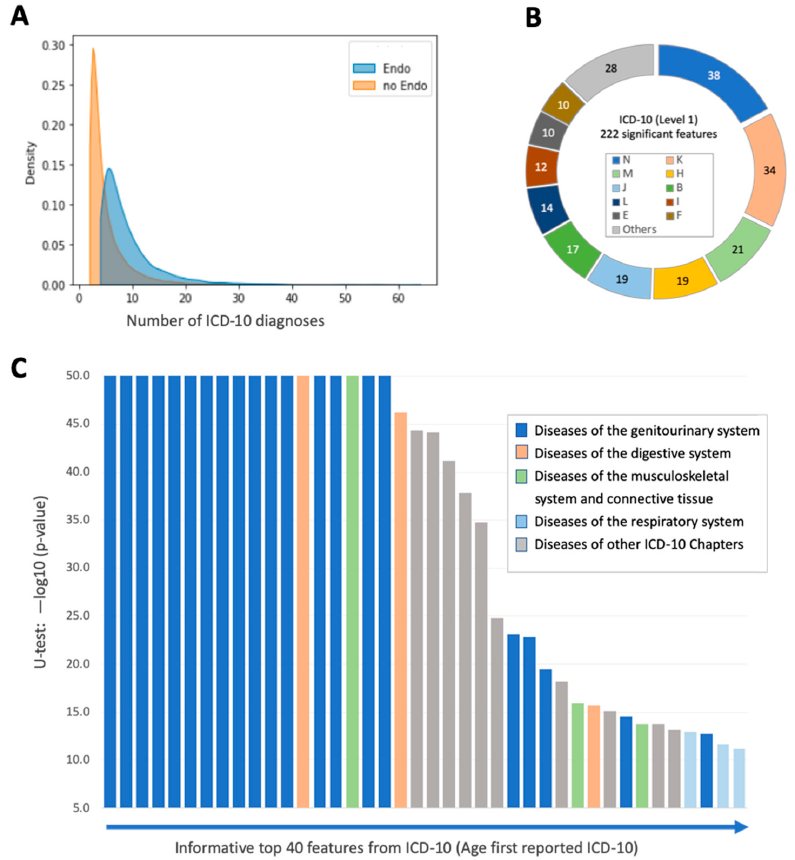
Figure 4. ICD-10 in control and endo-groups. ( A ) The distribution of the number of ICD-10 diagno- ses in the control and endo-groups (orange and blue, respectively) was significant using the Mann– Whitney U-test ( p -value < 0.001) and SMD = 0.471. The median value of the number of ICD-10 diag- noses per individual for the control and endo-groups is 1 and 4, respectively. ( B ) Partition of all 222 statistically significant informative features from the ICD-10 based model (U-test, p -value < 0.05). Each feature was tested for the statistical difference between the control and the endo-group. The partition is according to the ICD-10 level 1 first letter (A-Q). The level 1 letters with less than 10 features are unified (‘others’). ( C ) Ranked list of the top 40 ICD-10 that statistically differentiate ranked by the p -value < 1 × 10 − 11 . These 40 ICD-10 codes are color coded as in B by level 1 ICD-10 index. Detailed information on the listed features and ICD-10 level 4 information is available in Supplementary Table S3. Supplementary Table S3 shows the percentage of ICD-10 terms associated with women with and without endometriosis for 755 age-associated diagnoses (see Methods). While only 7% of the control group had >10 ICD-10 diagnoses, as many as 11% of the endo group had more than 30 ICD-10 diagnoses. Each age-converted ICD-10 was tested for the statistical difference between the control and the endo-group. For 222 items, the “age of first reported diagnosis” resulted in p -value < 0.05 in a non-parametric statistical test (Sup- plementary Table S3). Figure 4B shows the partition of these 222 items according to the ICD-10 indexing method (level 1; marked A to Q; Supplementary Table S4). The abundant ICD-10 level 1 includes diseases of the genitourinary system (N), followed by diseases of the digestive system (K), diseases of the musculoskeletal system and connective tissue (M) and diseases of the respiratory system (J). The significance of diseases of the respiratory system (J) and viral and parasite infection (B) is less evident.